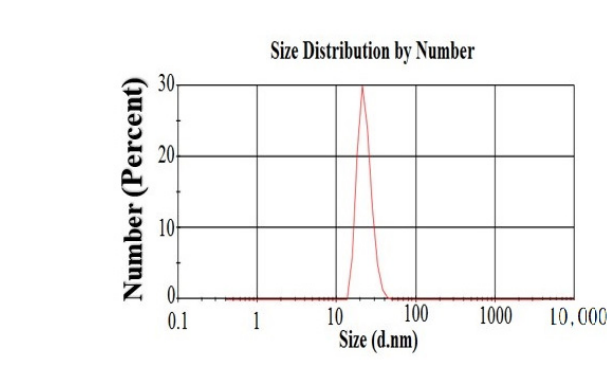
Table 1. Physico-chemical characteristics of soil and cow manure.